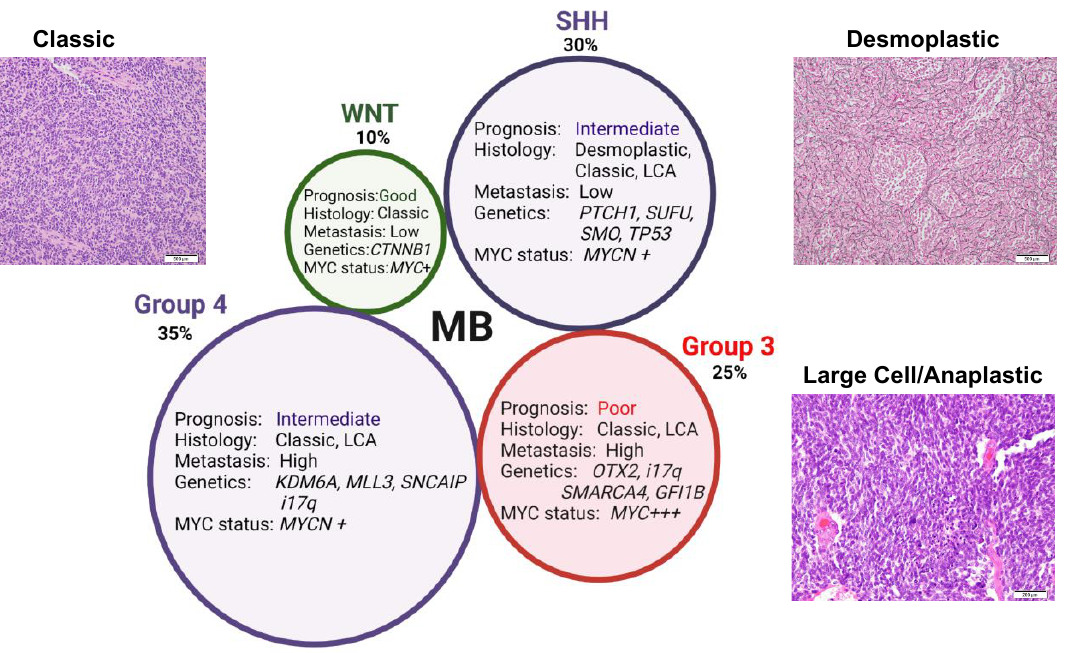
Figure 2. Medulloblastoma subgroup features and characteristics. Schematic depicting the four pri- mary medulloblastoma subgroups and their unique features. Regarding histology, classic tumors are characterized by sheets of small, round, monomorphic cells possessing high nuclear-to-cytoplasmic ratios and hyperchromatic nuclei. Desmoplastic tumors are characterized by nodules of tumor cells displaying neurocytic differentiation within pale islands. Large cell/anaplastic tumors feature cells with nuclear enlargement, hyperchromatism, a high mitotic index, and atypical mitotic figures. Hematoxylin and eosin staining, 200–500X magnification. (Images courtesy of Deborah Perry, Children’s Hospital & Medical Center, NE). CTNNB1, catenin beta 1; GFI1B, growth factor 1B transcriptional repressor; i17q, isochromosome 17q; KDM6A, lysine demethylase 6A; LCA, large cell anaplastic; MLL3, mixed lineage leukemia protein 3; MYC, cytoplasmic MYC proto-oncogene; MYCN, nuclear MYC proto-oncogene; OTX2, orthodenticle homeobox 2; PTCH1, patched-1; SMARCA4, SWI/SNF- related, matrix-associated, actin-dependent regulator of chromatin, subfamily A member 4; SMO , smoothened; SNCAIP, synuclein alpha-interacting protein; SUFU, suppressor of fused; TP53, tumor protein